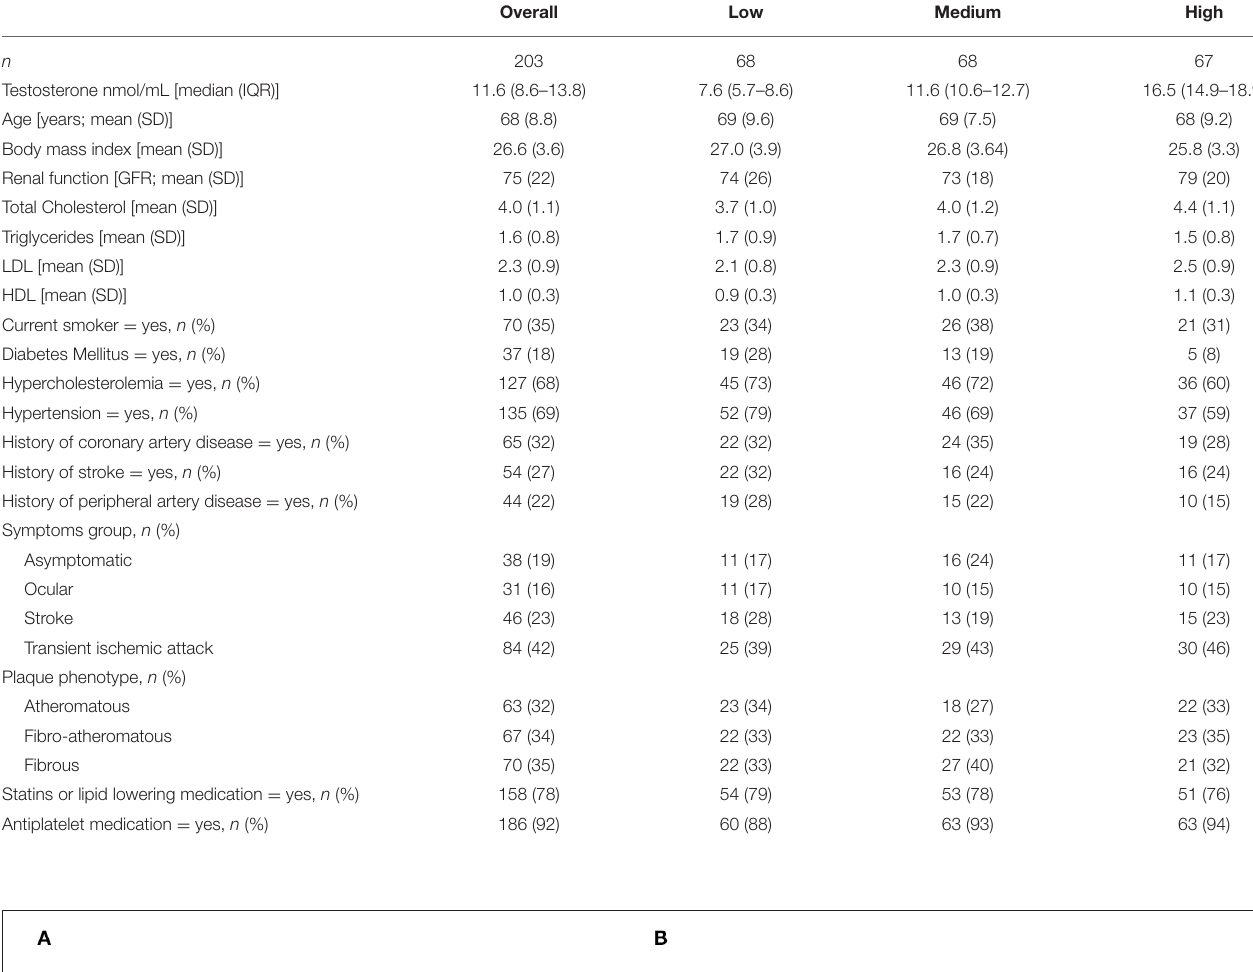
TABLE 1 | Baseline characteristics by testosterone tertiles of men undergoing carotid endarterectomy.